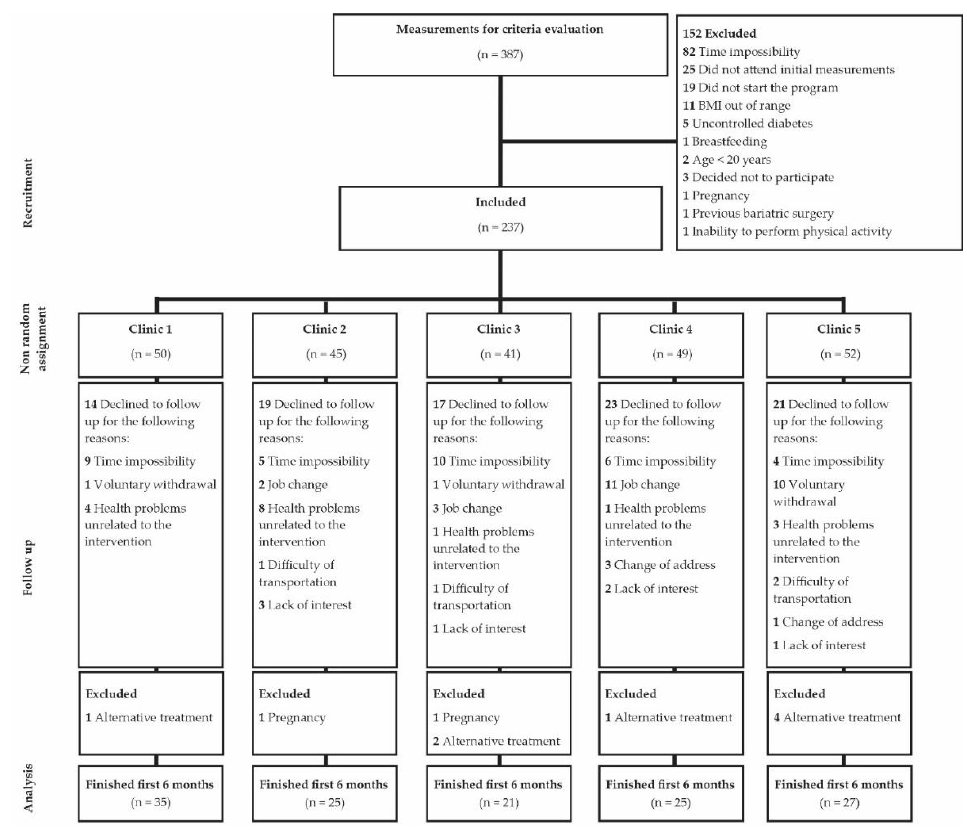
Figure 1. Flow diagram of study participants in the five clinics through the 6 months of intervention. Table 2. Baseline characteristics of participants completing the 6 months of intervention ( n = 133).